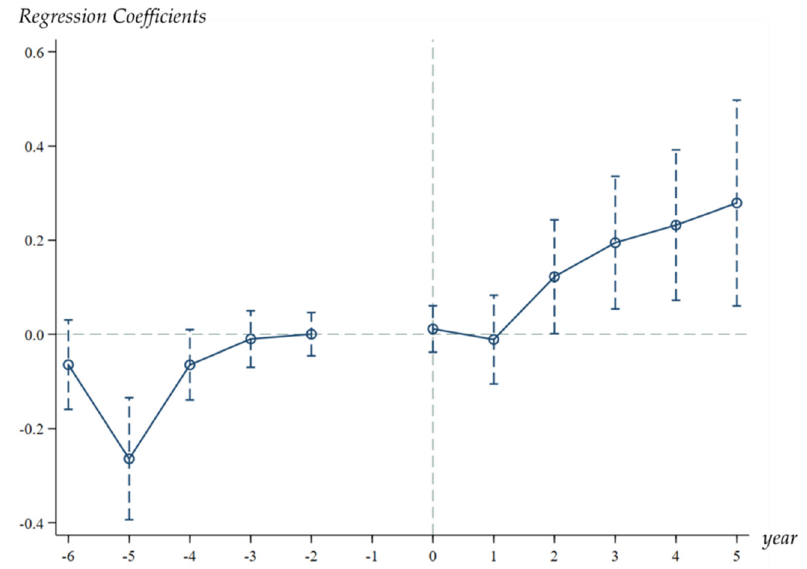
Figure 1. Test for parallel trends.